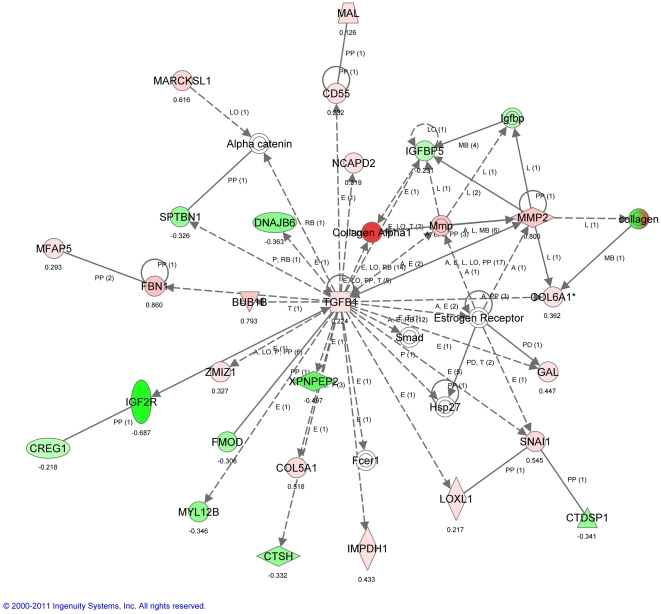
Ingenuity Pathway Analysis (IPA) of transcriptomic patterns 7 days after PNX.Top network illustrates transcripts that are significantly modulated in a whole lung analysis 7 days after PNX in 9 vs. 3 month mice. Green indicates down-regulated transcripts, red indicates up-regulated transcripts. Key: The node shapes denote - enzymes  phosphatases  kinases  peptidases  G-protein coupled receptors  transmembrane receptors  cytokines  growth factors  ion channels  transporter  transcription factor  other .